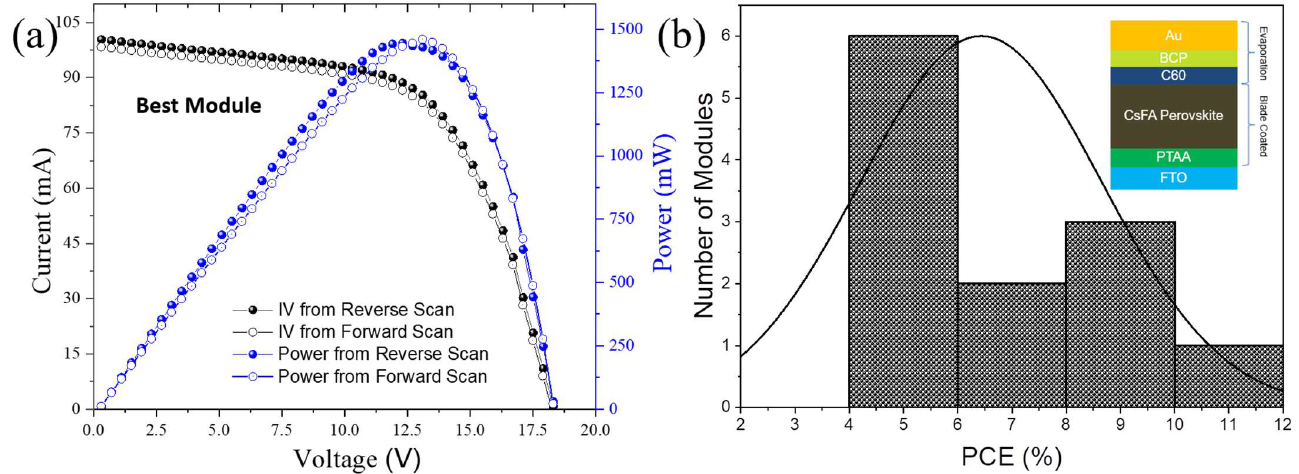
Figure 6. ( a ) IV and PV parameters of the best-performing module, with a PCE of 10.4%. ( b ) Statistics of the module performances before the lamination process, with a scheme of the architecture and deposition techniques used. Table 4. Photovoltaic parameters of the 12 modules designed with 18 series of connected cells, each with an active area of 201 cm 2 , assembled in the panel.